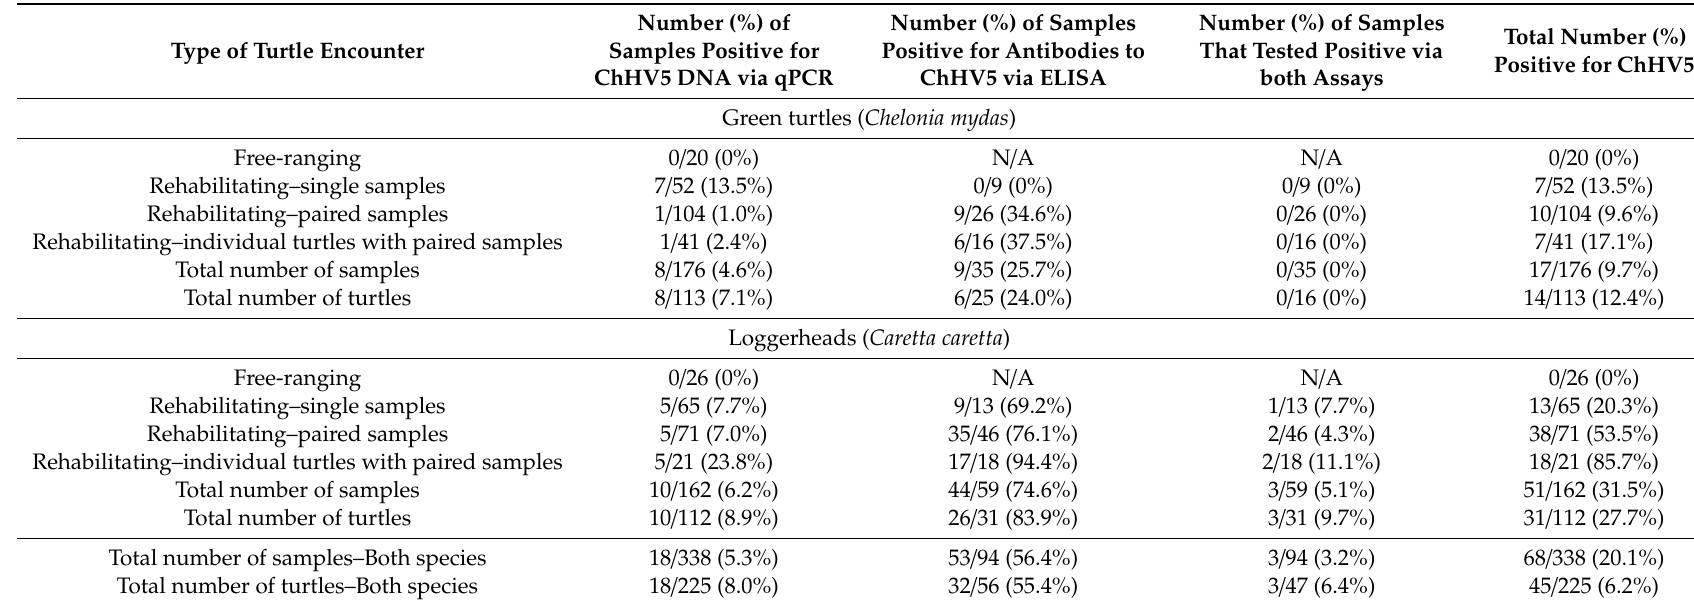
Table 2. Qualitative results for the samples tested using quantitative polymerase chain reaction (qPCR) to detect chelonid alphaherpesvirus 5 (ChHV5) DNA and using an enzyme-linked immunosorbent assay (ELISA) to detect antibodies to